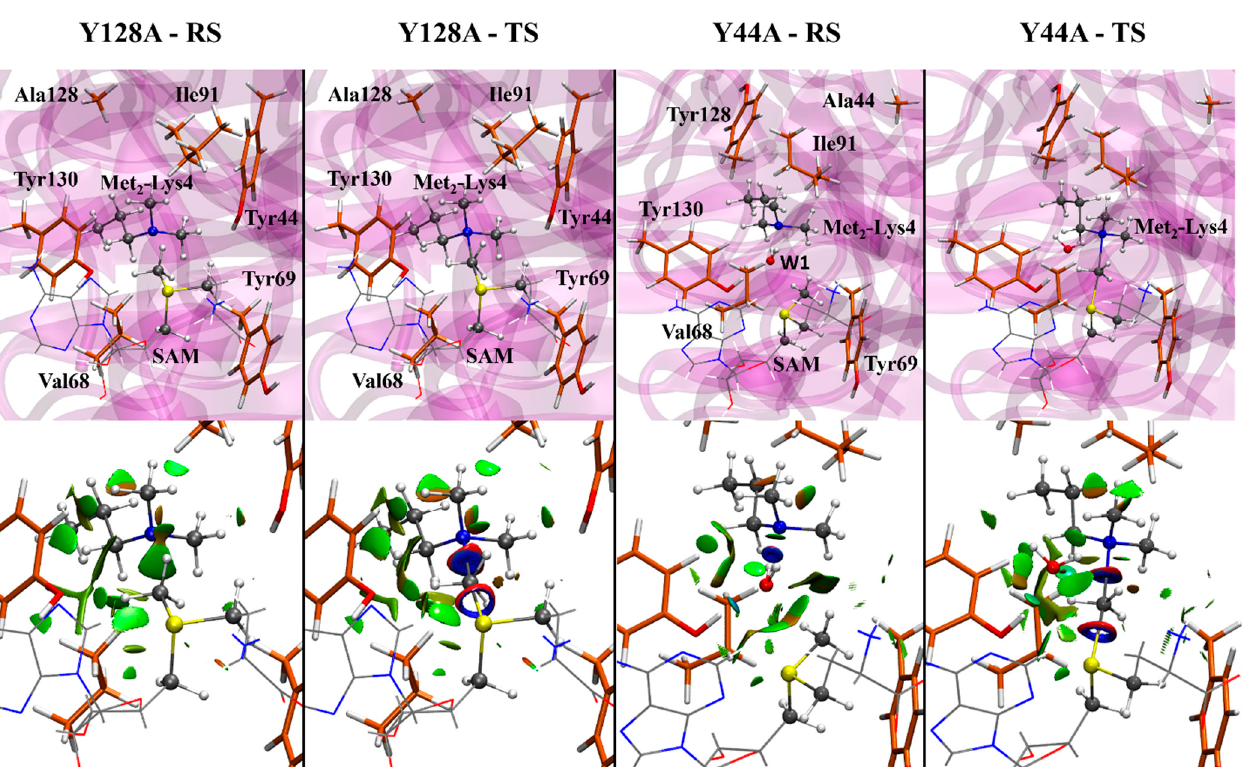
Figure 5. Structural representation of the catalytic site at the RS and TS for the tri-methyl-transfer reaction performed by the Y128A and Y44A mutants. Below, there is a graphic representation in real space of the non-covalent interactions occurring between the methyl group and the enzymatic environment, showing the stabilization at the RS of the dimethyl lysine at the binding site for Y128A aided by the mutation of the tyrosine by alanine (enzyme’s carbon—orange; substrate and cofactor carbon—gray; red—oxygen; blue—nitrogen; white—hydrogen; and the isovalue used as cutoff for the surface is defined as 0.5).